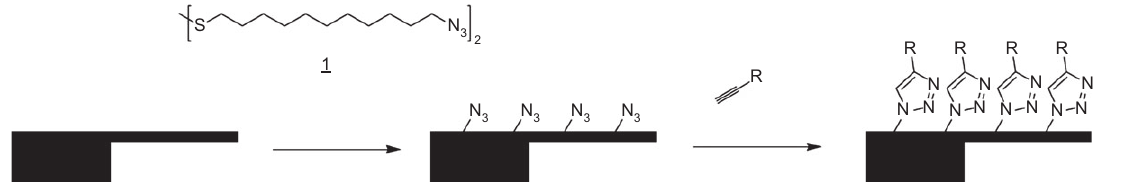
Figure 7 Cartoon representation of the functionalization of surface using “ click ” chemistry. Reproduced with permission from Paoloni et al. (2011)